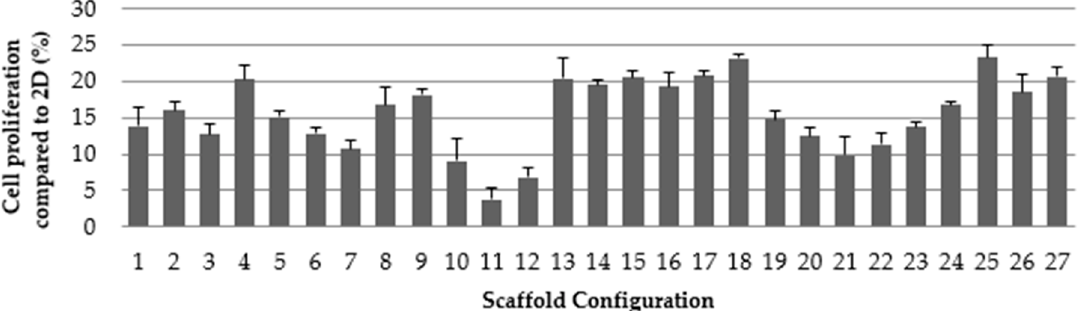
Figure 2. MDA-MB-231 cell proliferation for each PLA scaffold configuration (3D) as compared to a two-dimensional surface (2D) ( n = 3).